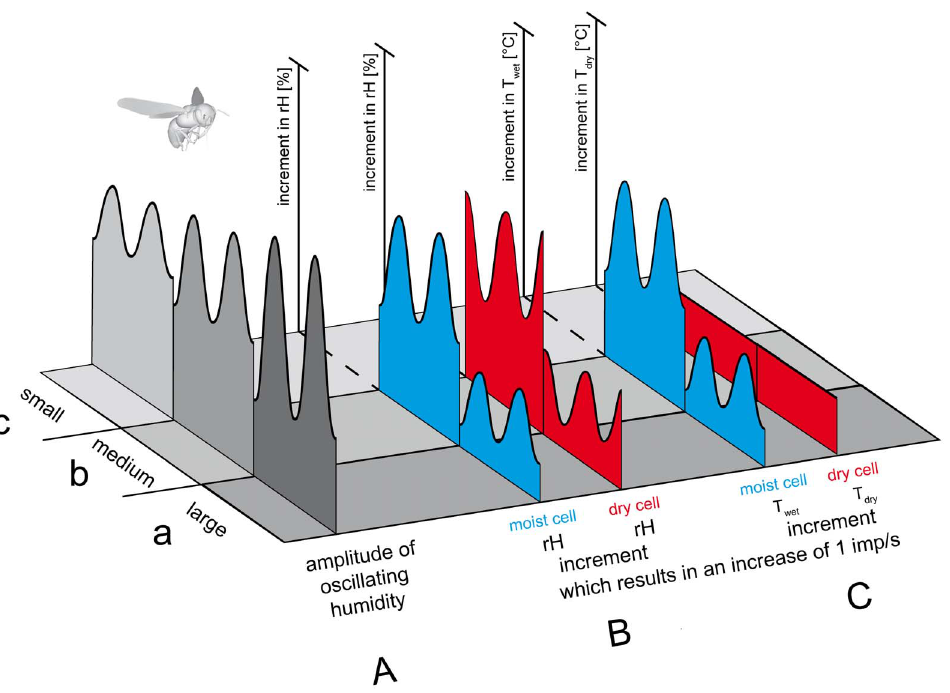
Figure 10. Sensitivity of a honeybee’s moist cell and dry cell for oscillating humidity changes with different amplitudes. Sensitivity is defined as the reciprocal of the stimulus increment regarded to produce a neural response of unit size (1 imp/s). A. Amplitude of humidity oscillations. a small amplitude oscillations, b medium amplitude oscillations, c large amplitude oscillations. B . Sensitivity of moist and dry cells that measures the relative humidity of the air. a During small amplitude humidity oscillations the increments in relative humidity required for unit change in the discharge rates of the moist and dry cells are large. b During medium amplitude humidity oscillations, somewhat smaller increments in relative humidity are required for unit change in the discharge rates of the moist and dry cells. c During large amplitude humidity oscillations, small increments in relative humidity may elicit the same unit change in the discharge rates of both cells.